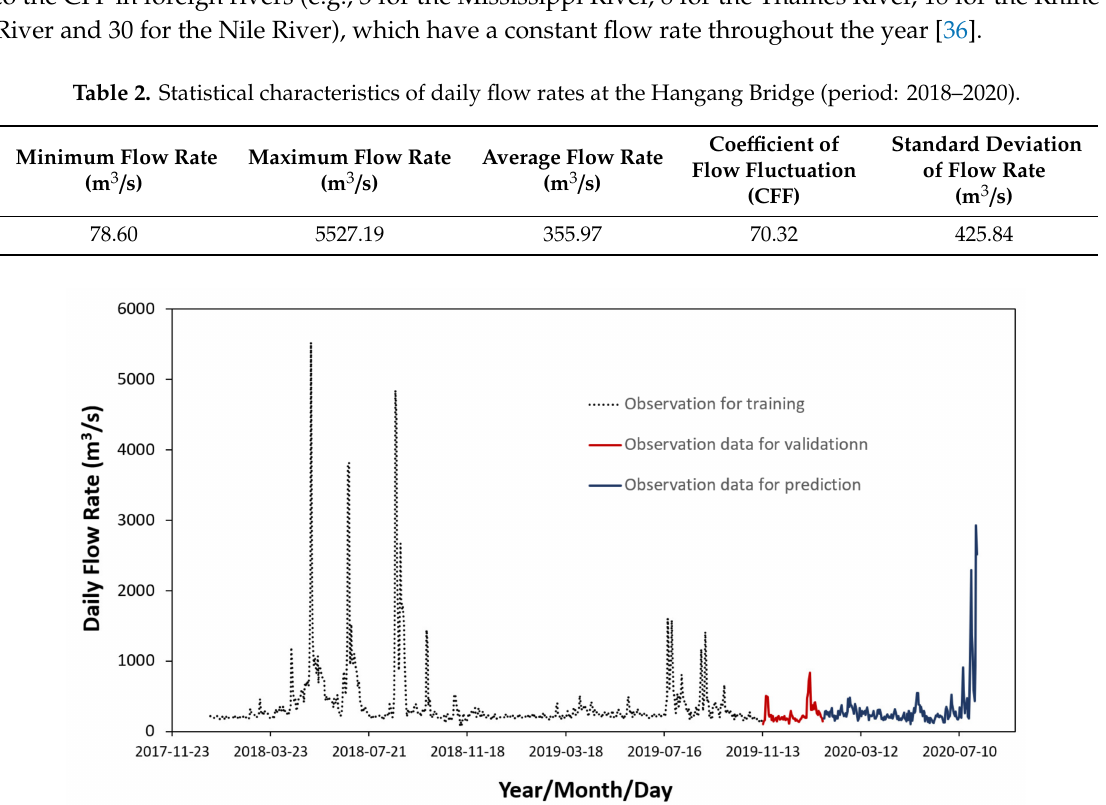
Figure 7. Time series daily flow rates at the Hangang Bridge (period: